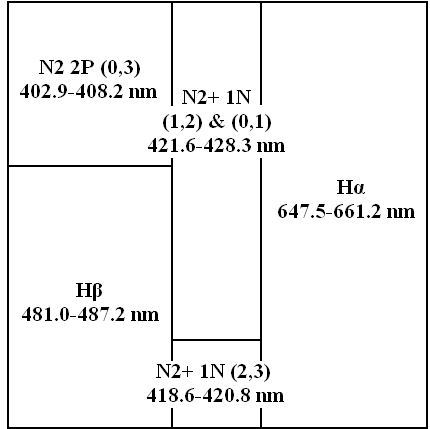
Fig. 1. The HiTIES spectrograph is equipped with a 50 × 50mm square mosaic consisting of five interference filters. The 8 ◦ field of view is on the horizontal axis and wavelength on the vertical axis.